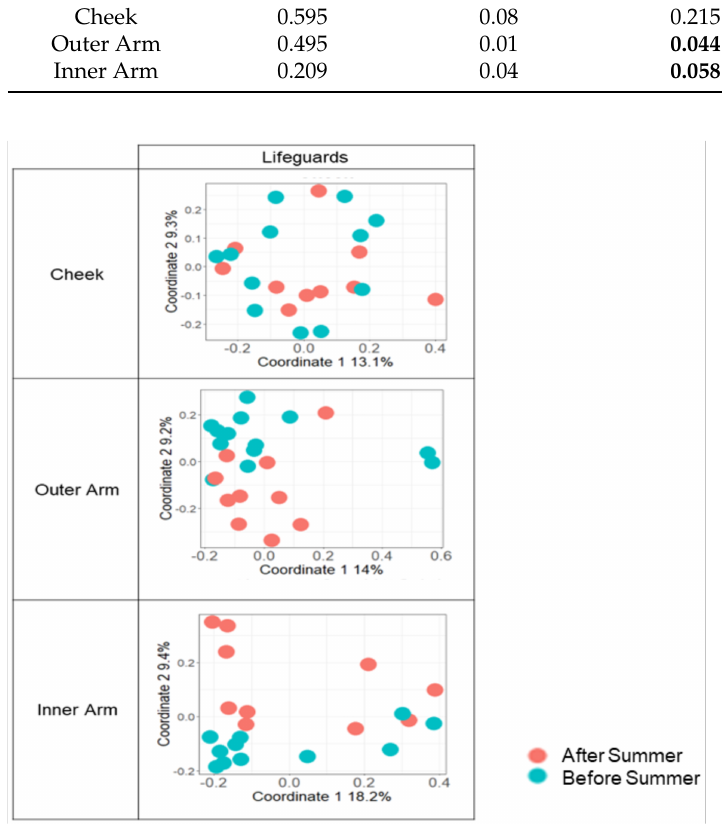
Figure 5. Seasonal differences of lifeguard’s skin microbiome across several body sites. PcoAs of Jaccard distance matrices are shown. Orange—after the summer; blue—before the summer. The percentage of variance is shown for each axis; ANOSIM p and R values were calculated for each facet and are shown in Table